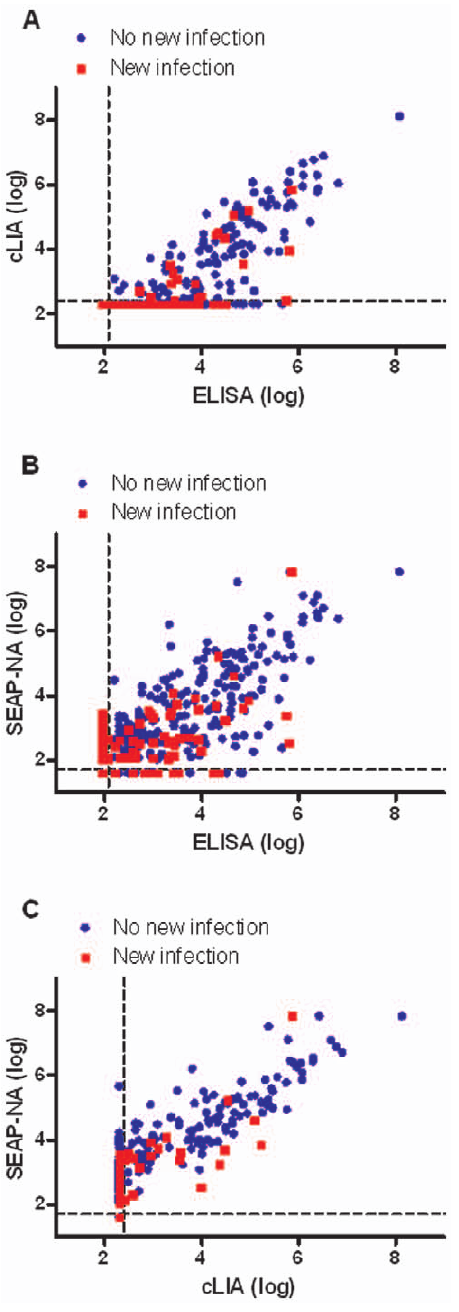
Figure 2. Graphical presentation of the results comparing each assay by new infection status. The results are plotted on the log scale for each assay; the dashed lines represent the standard cutoffs for seropositivity for the assays. (A, B, C) Blue points represent enrollment serology results for those subjects who did not have an incident HPV16 infection, and red squares represent enrollment serology results for subjects for whom we detected an incident HPV16 infection. New infection was detected over four years of